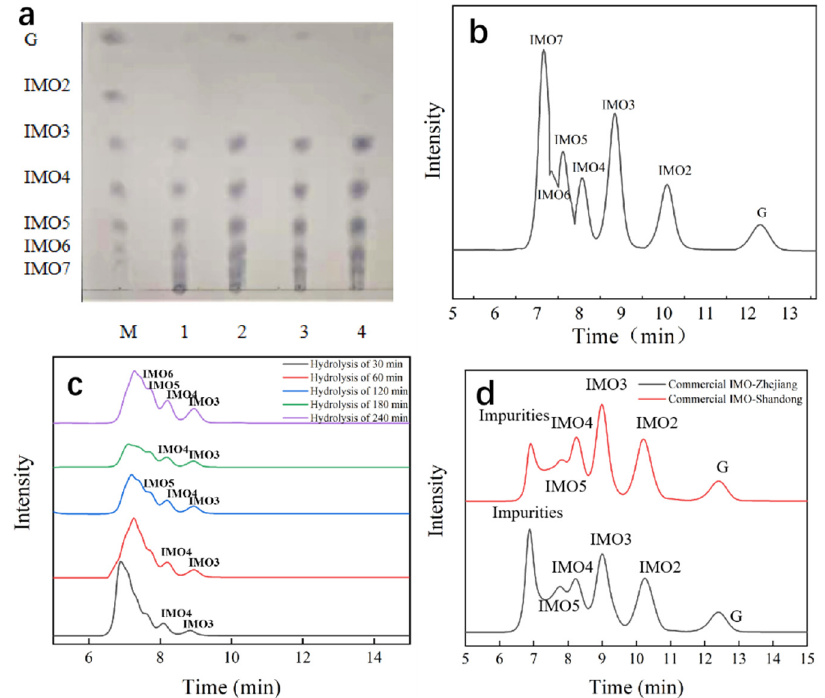
Figure 4. Analysis of hydrolysis products of PsDex1711. ( a ) TLC analysis: M (standard: glucose,